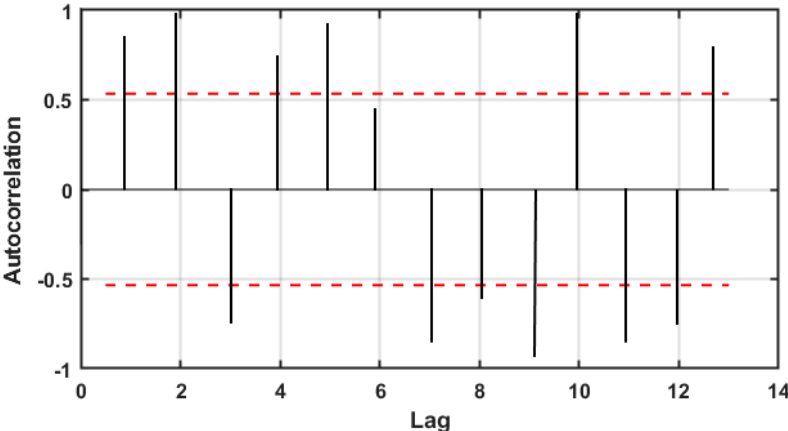
Figure 5. An autocorrelation plot showing the correlation between features.